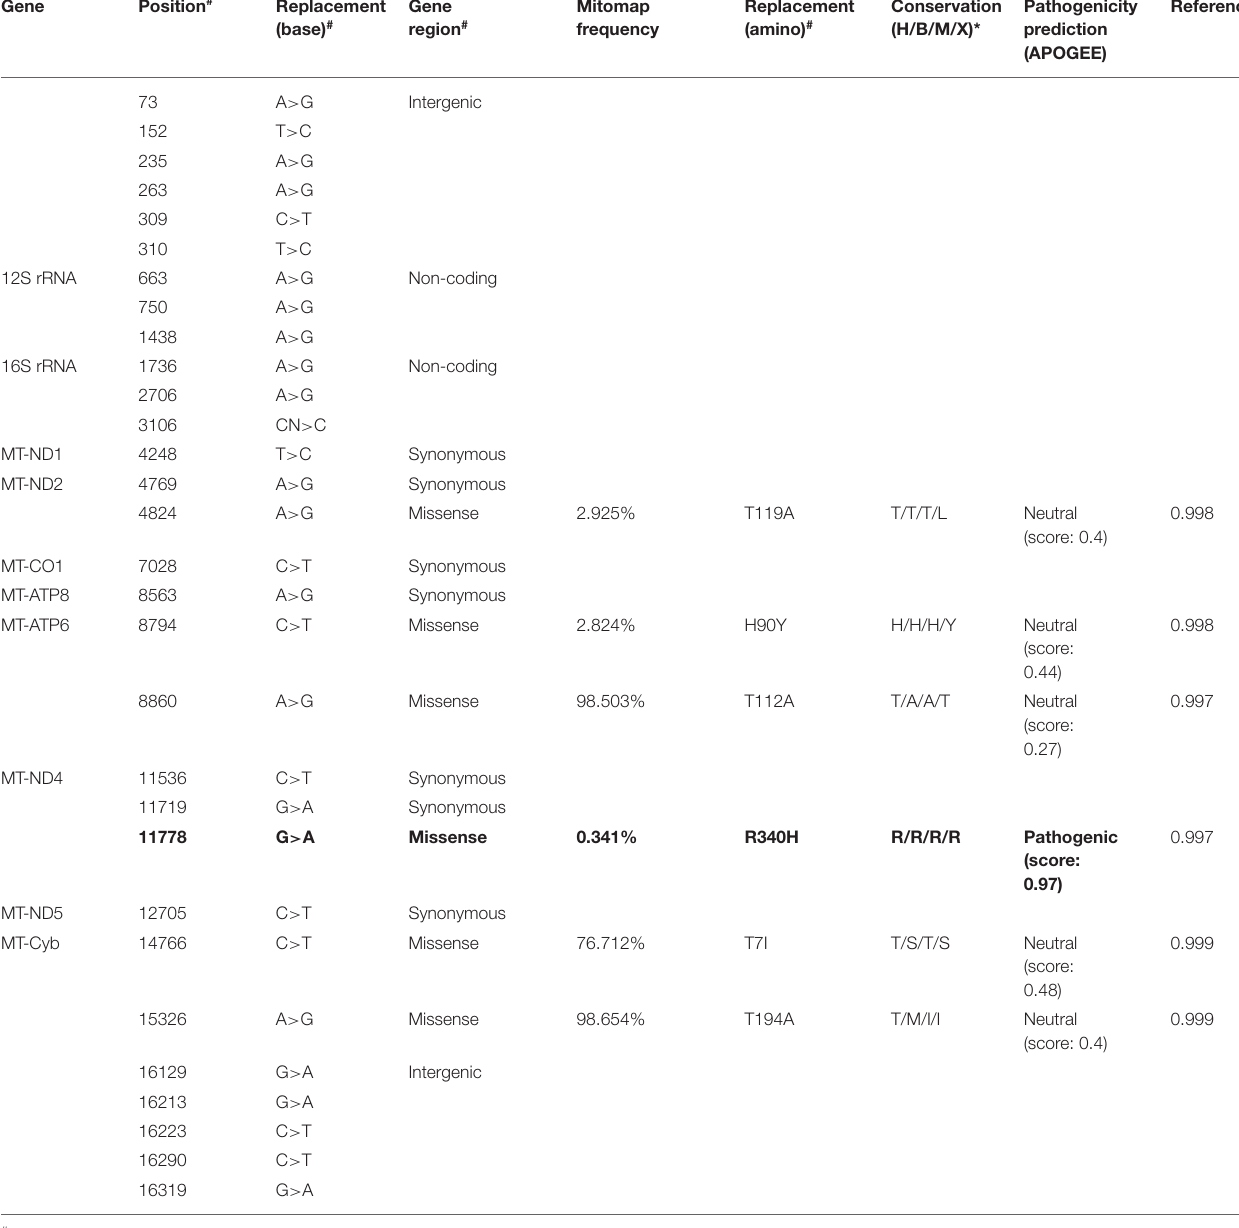
TABLE 1 | The mitochondrial DNA gene (mtDNA) variants in the mild patient (III-4). Gene Position